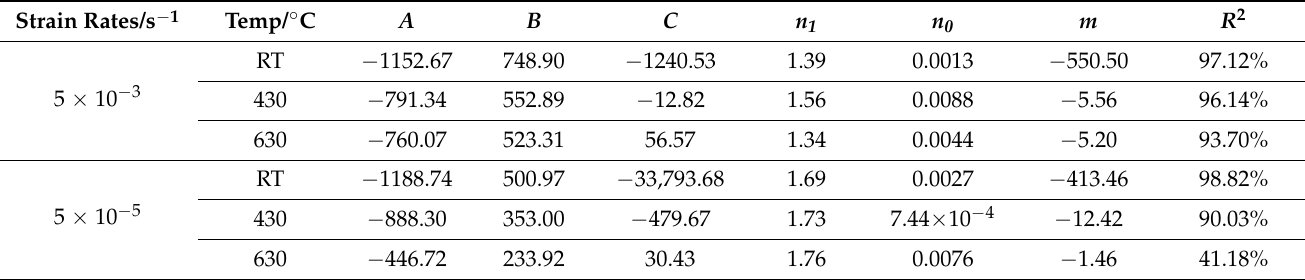
Table 4. Fitted values of the KHL model under different temperatures at strain rates of 5 × 10 − 3 s − 1 and 5 × 10 − 5 s − 1